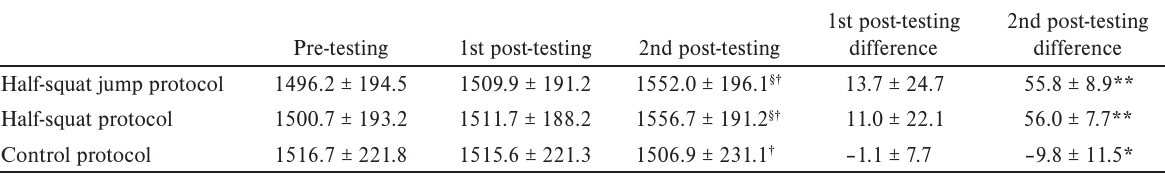
Half-squat jump power values (in Watts) before and after conditioning